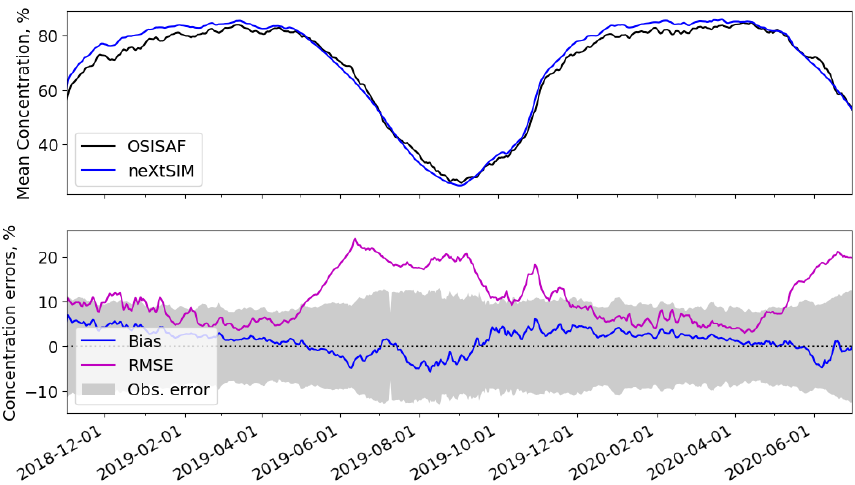
Figure 2. Temporal comparison of model and OSI SAF SSMIS concentrations. The shaded area in the lower plot shows the rms uncertainty of the concentration for reference when considering the errors. The mean concentration is the mean over the ocean points in the domain, while the bias is defined as the mean error (model minus observation) over the region where either the model or observations have ice.